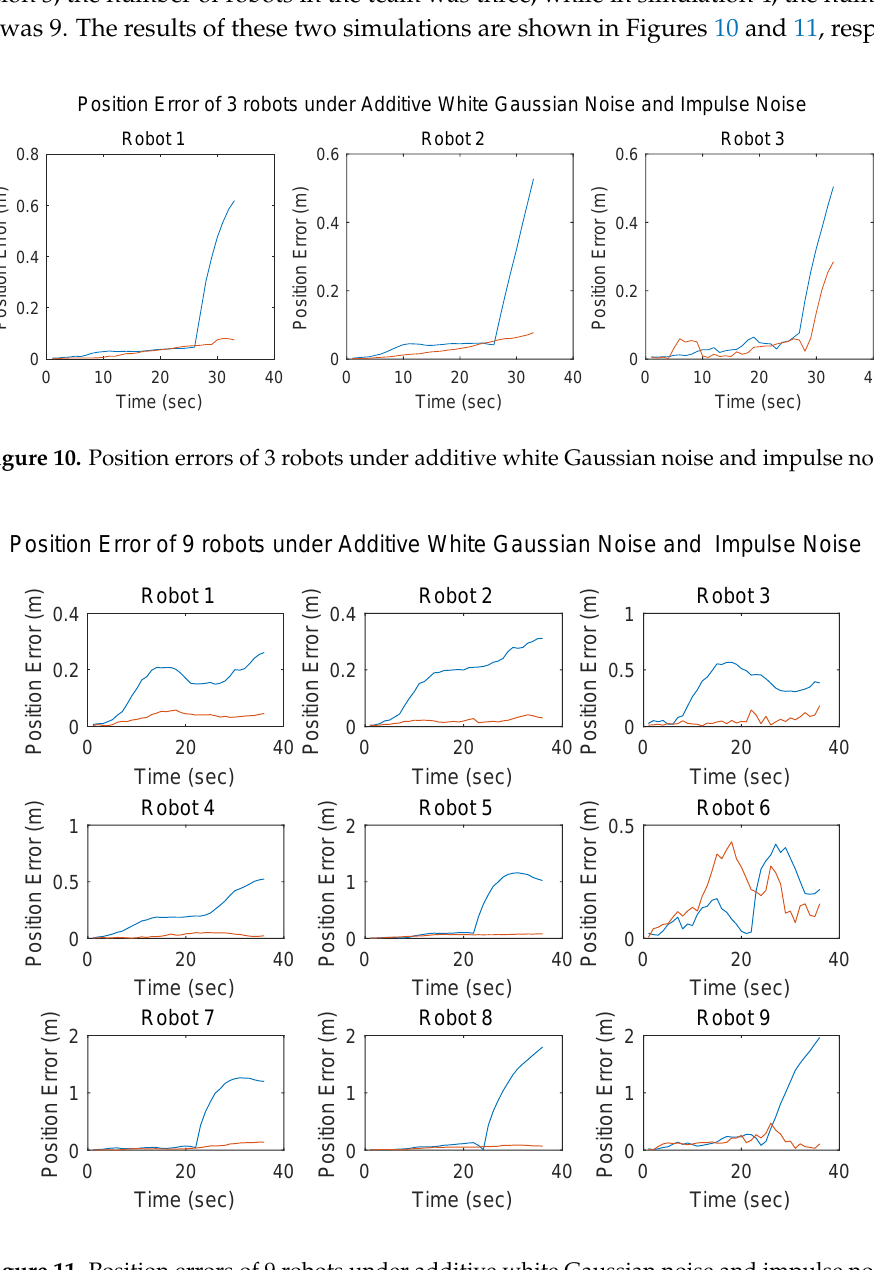
Figure 11. Position errors of 9 robots under additive white Gaussian noise and impulse